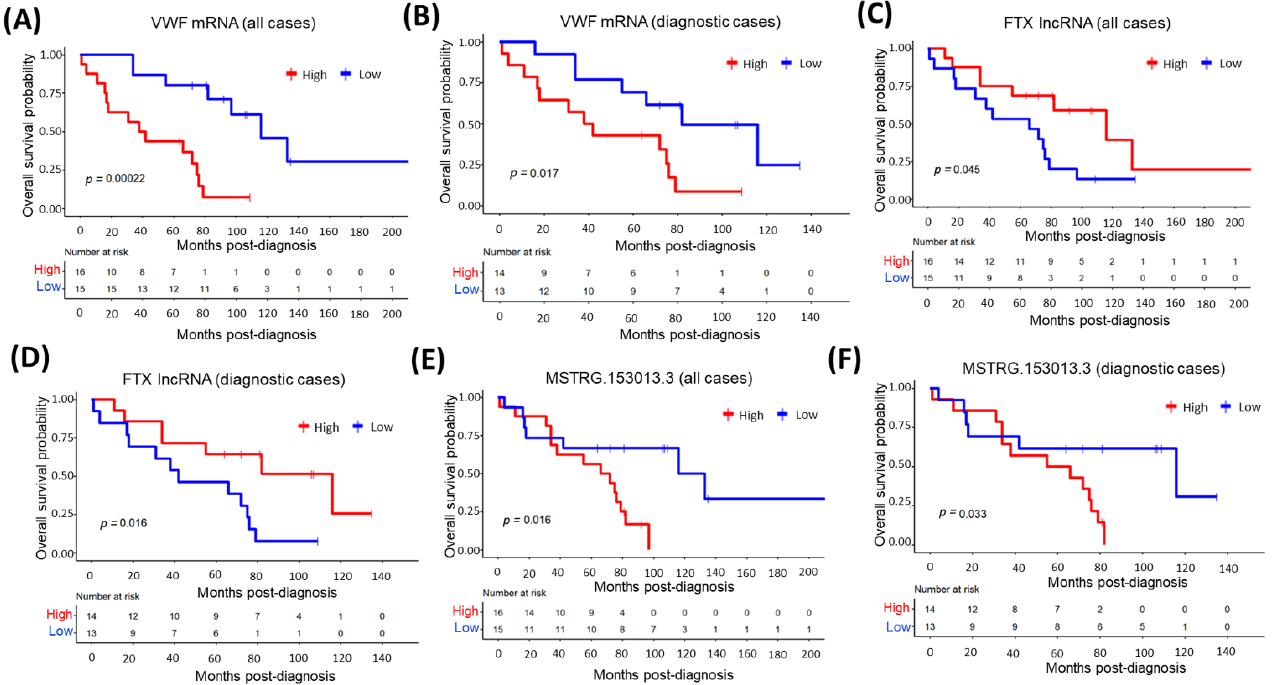
Figure 9. Top overexpressed transcripts significantly associated with MCL overall survival. MCL cases were dichotomized based on the mRNA or lncRNA expression levels of the top 10 cancero- genesis-related genes or the top 20 upregulated alternative transcripts. Kaplan–Meier curves of VWF mRNA ( A , B ), FTX lncRNA ( C , D ) and MSTRG.153013.3 alternative transcript ( E , F ) whose ex- pression are significantly associated with poor or good overall survival in all ( A , C , E ) or diagnostic cases ( B , D , F ). p < 0.05 is considered statistically significant. High : High transcript expression. Low: Low transcript